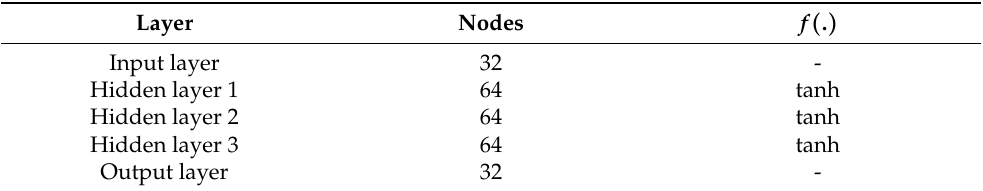
Table 2. The architecture setup of the FDNN-based channel estimation.